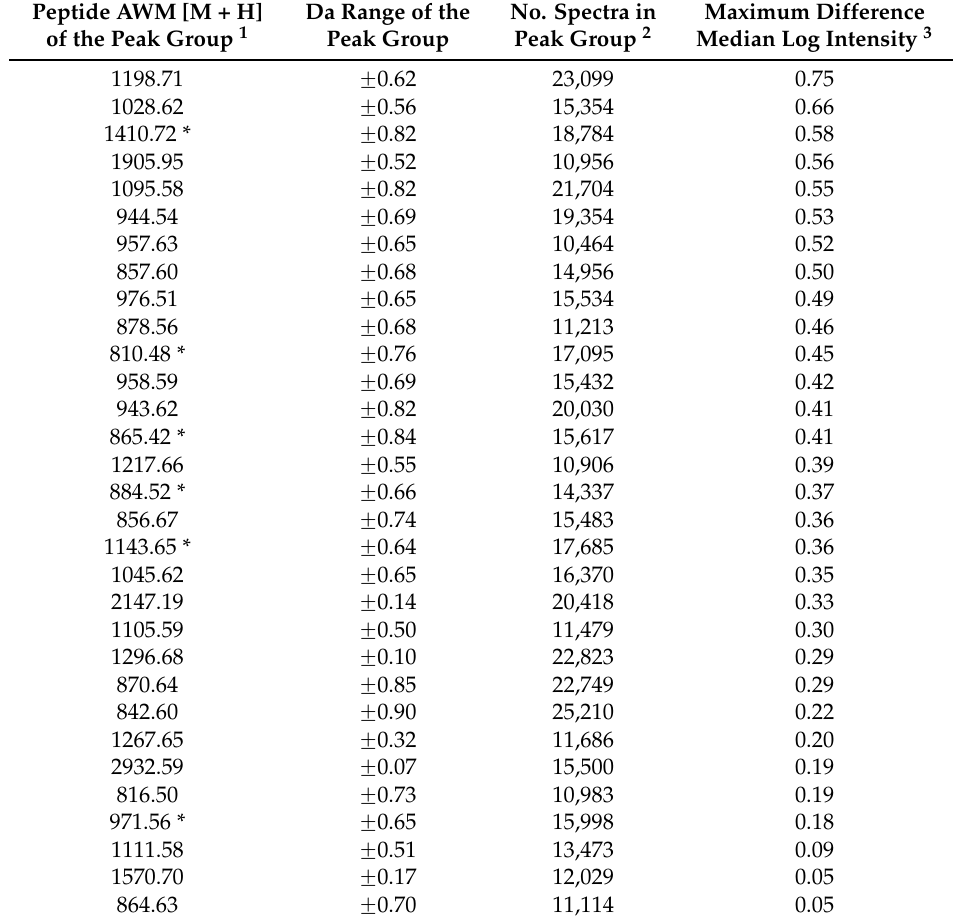
Table 1. Matrix-assisted laser desorption/ionization mass spectrometry imaging peak groups ranked heuristically by the largest difference in median log intensity between the healthy